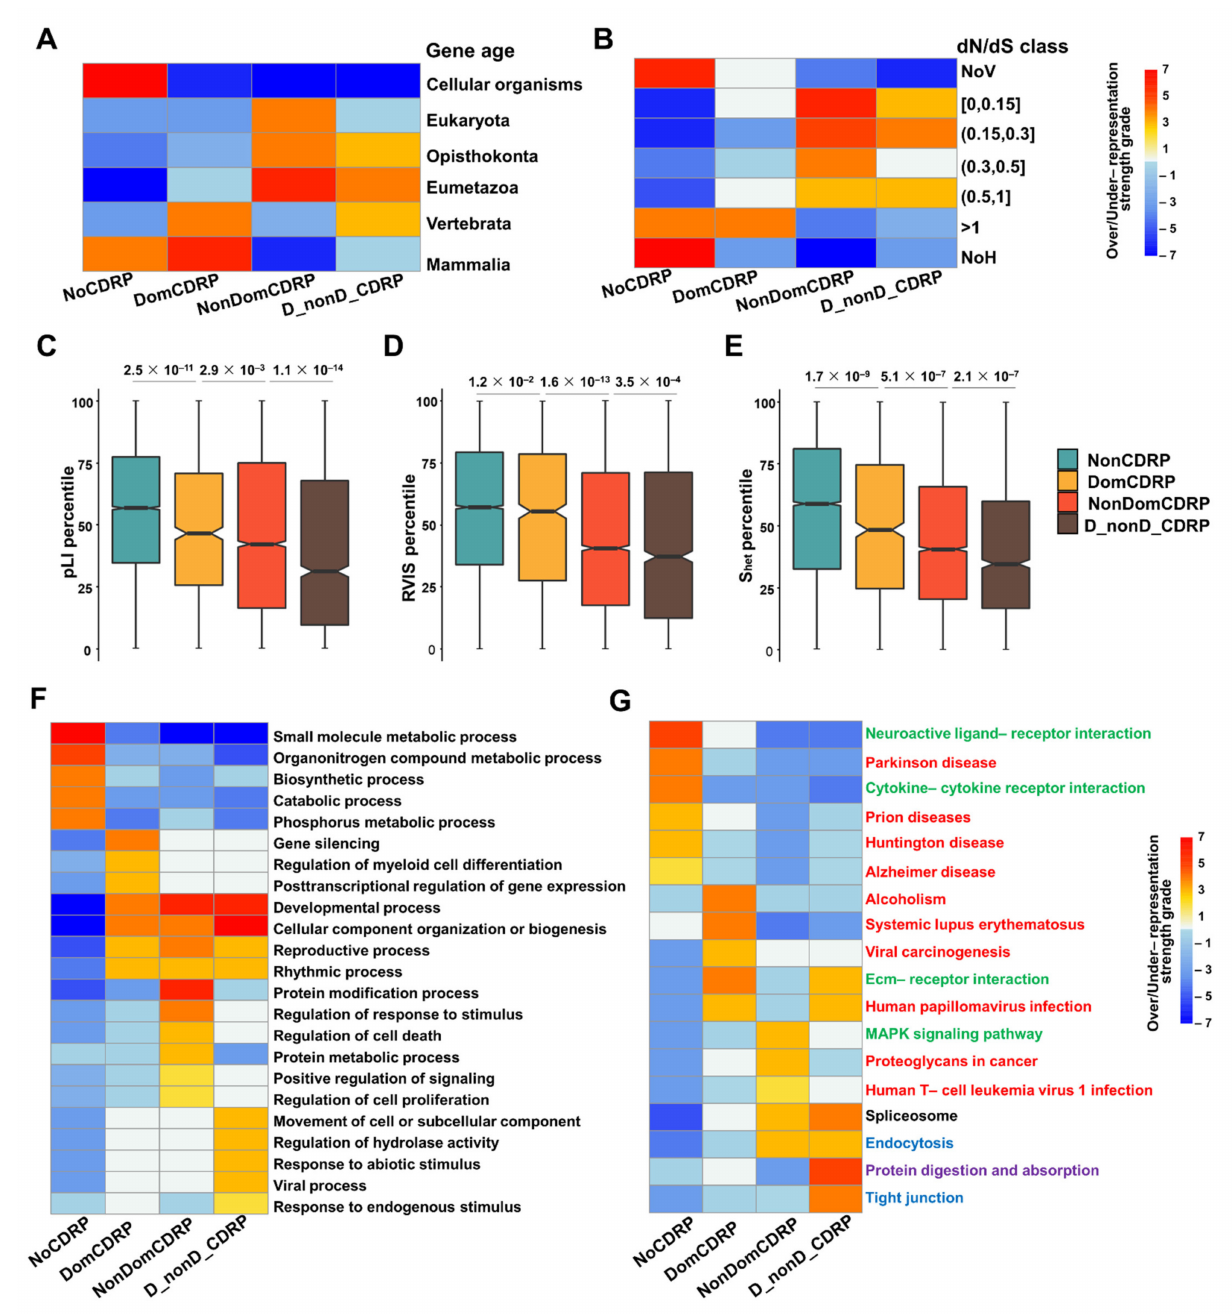
Figure 3. The evolutionary and functional characteristics of the four classes of proteins. Over- or under-representation strengths of the four protein categories in gene-age ( A ) or dN/dS ( B ) classes. NoV means no variation between the orthologs of human and chimpanzee. NoH means no homologs between human and chimpanzee. ( C – E ) Comparison of the tolerance to functional variation among the four types of proteins. The residual variation intolerance score (RVIS), the probability of being intolerant to loss-of-function mutations (pLI), and the selection against heterozygous loss of gene function (S het ) scores are further transformed into percentiles. Significance was measured by the Wilcoxon rank sum test and p -values were adjusted by step-down Bonferroni. ( F , G ) Over- or under-representation analysis of biological process (BP) and KEGG pathways for the four types of proteins. The over- or under-representation strengths ( A , B , F , G ) are represented by − log (p) or log (p), respectively. Heat maps show the grades of over- or under-representation strengths, scoped from − 7 to 7. Red terms belong to the “Human Diseases” class; green terms belong to “Environmental Information Processing” class; blue terms belong to the “Cellular Processes” class; purple terms belong to the “Organismal Systems” class and the black term belongs to the “Genetic Information Processing”